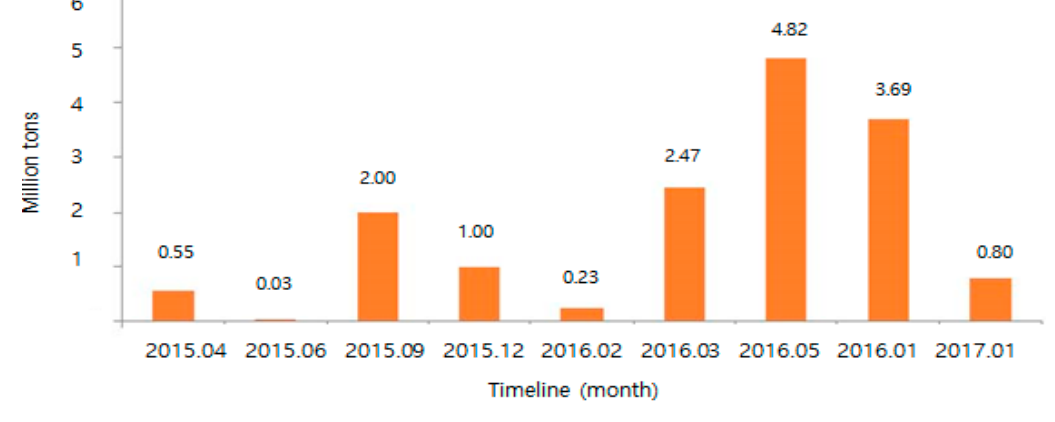
Figure 5. Trend in certified reductions in millions of tons. Source: Ministry of Environment and Ministry of Strategy and Finance.